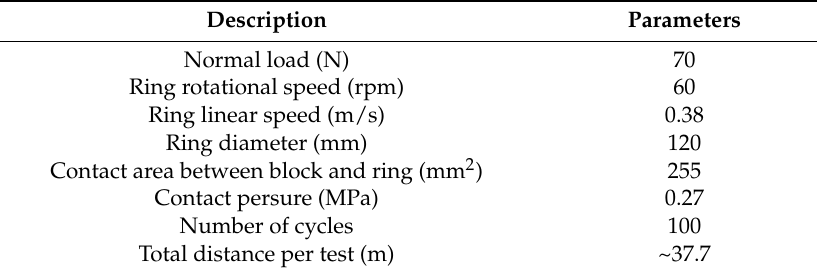
Figure 2. Block-on-ring configuration view. Table 2. Tribological parameters used in block-on-ring configuration.